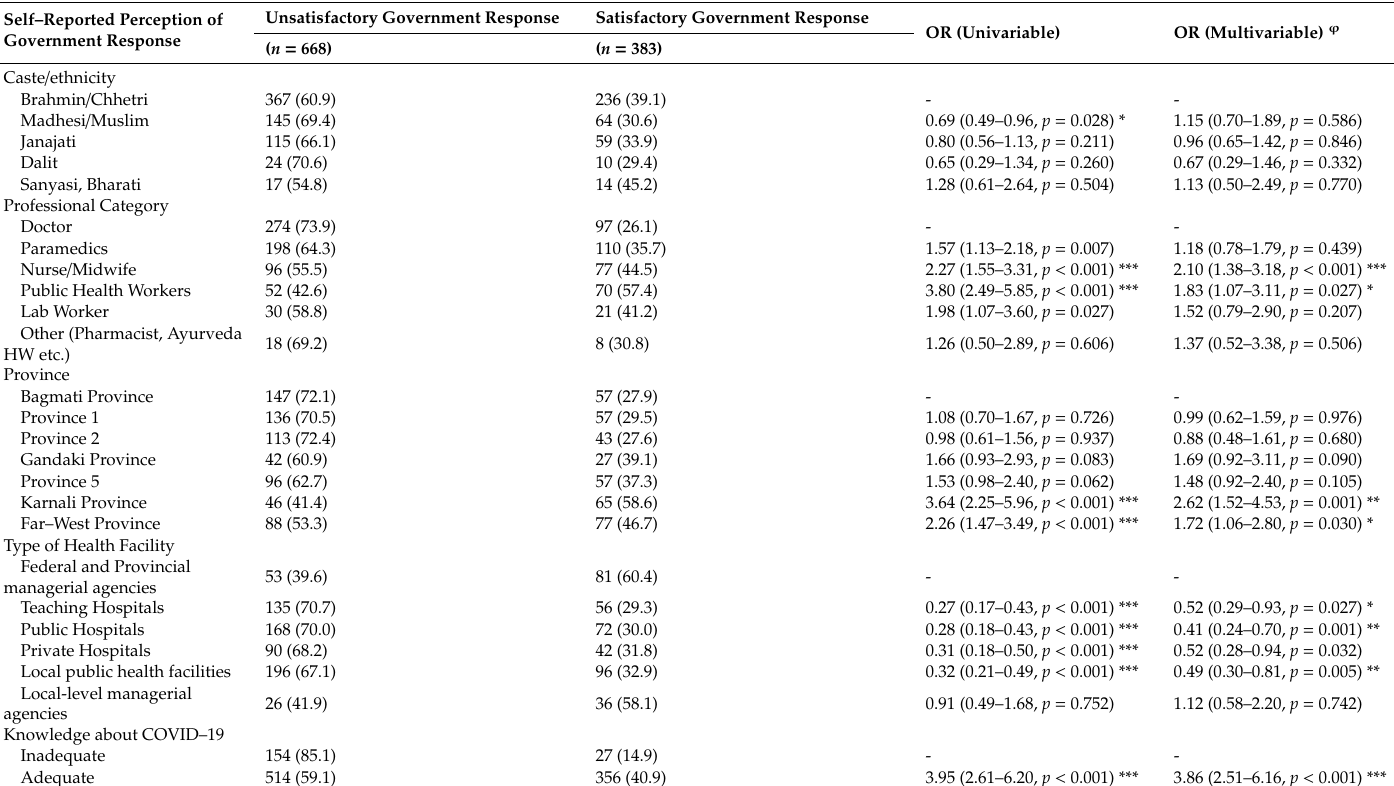
Table 3. Factors associated with self-reported perception of government response to COVID-19